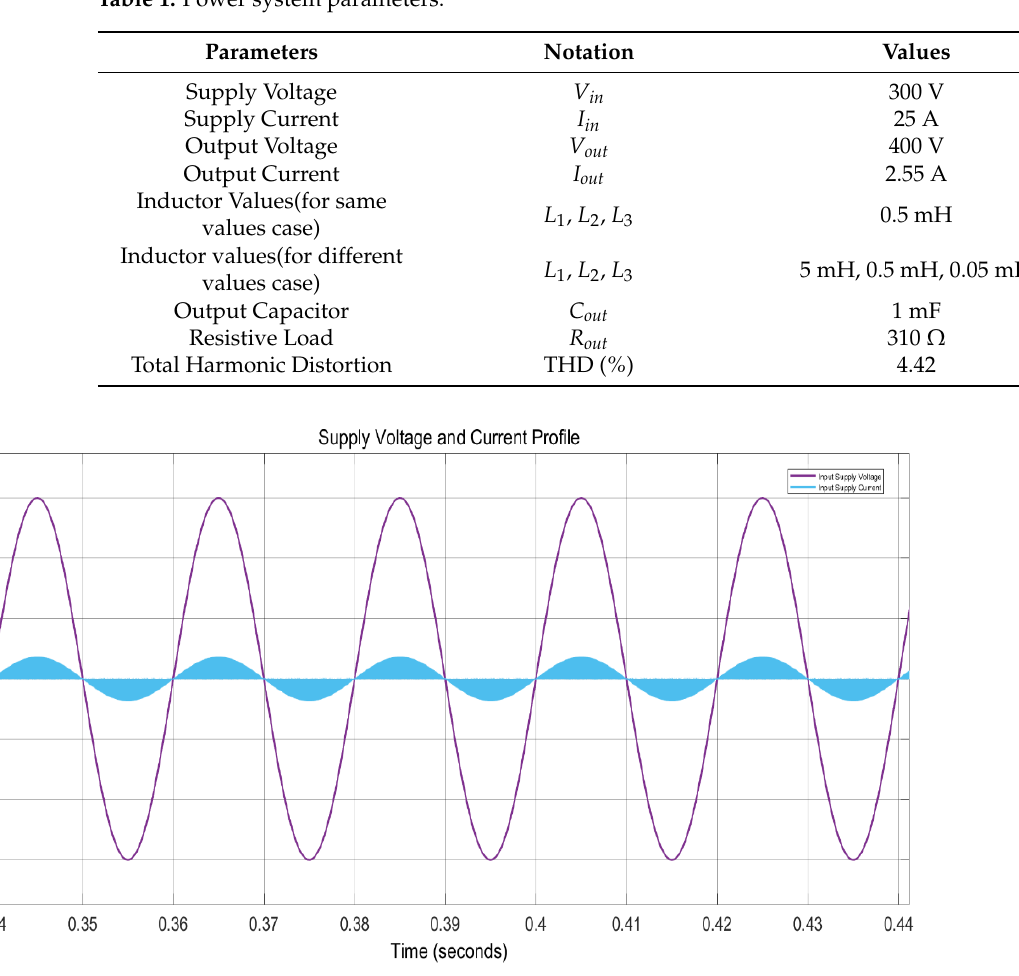
Table 1. Power system parameters.